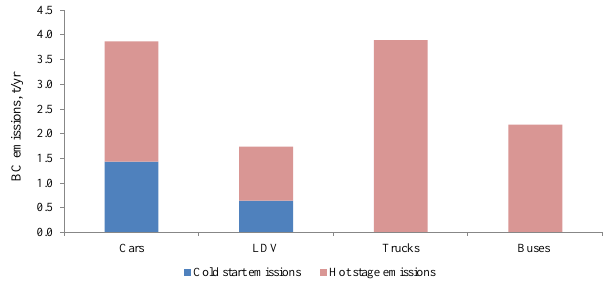
Figure 1. Cold start and hot stage BC emissions in Murmansk City by vehicle type (t).